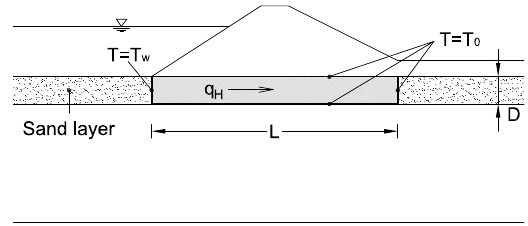
Figure 13. Domain (grey rectangle) and boundary conditions as- sumed for the calculation of the geothermal Péclet number.